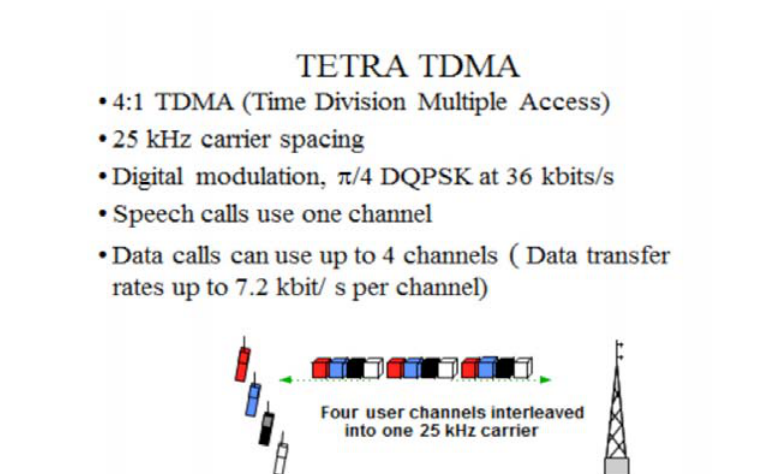
Figure 4 – Representation of TDMA, parameters and spectral efficiency in the TETRA Standard 1 (123seminarsonly, 2004) Рис . 4 – Представление TDMA, параметров и спектральной эффективности в TETRA 1 (123seminarsonly,